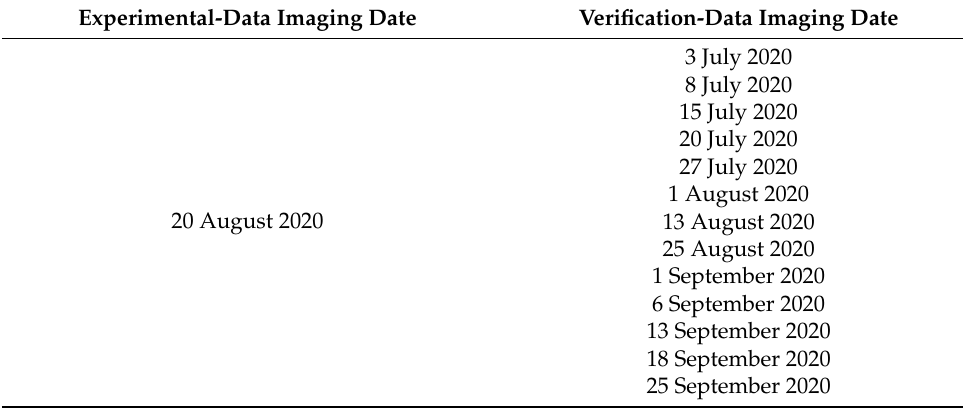
Table 2. All Sentinel-1 SAR data were involved in the study.